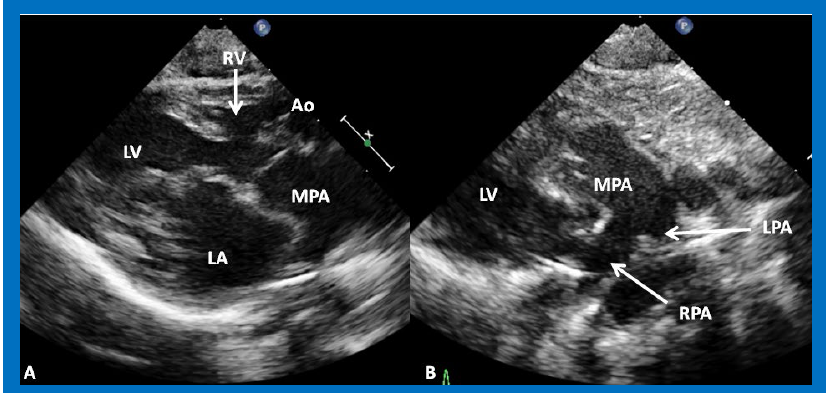
Figure 11. ( A ) A selected video frame from parasternal long axis views of a patient with tricuspid atresia and transposition of the great arteries demonstrating the left atrium (LA), left ventricle (LV), a very small right ventricle (RV) and a moderate sized ventricular septal defect (not marked). The vessel coming off the LV is traced in ( B ) and shown to bifurcate into the left (LPA) and right (RPA) pulmonary arteries, confirming that this vessel is the main pulmonary artery (MPA), consistent with transposition of the great arteries. Ao, Aorta. Reproduced from Reference [29].